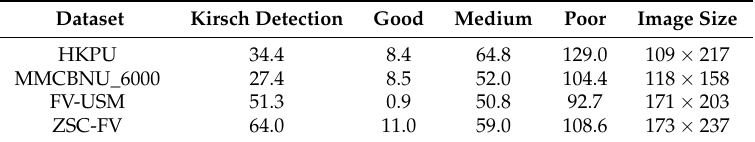
Table 3. Statistics on the average computation time (milliseconds) for the four